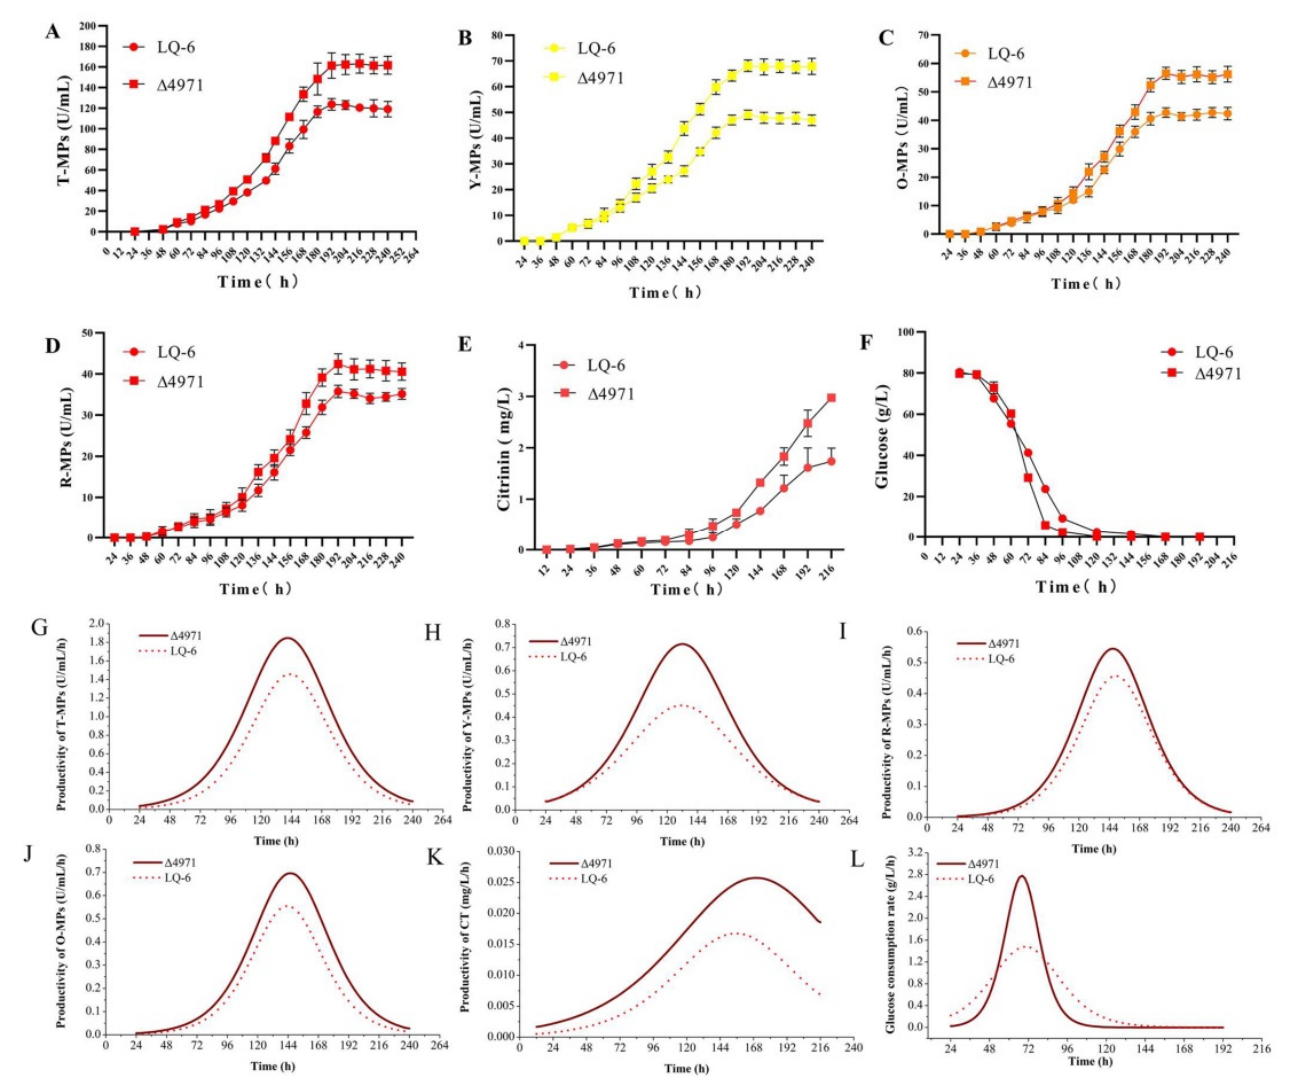
Figure 9. Submerged batch-fermentation kinetics analysis of M. purpureus LQ-6 and M. purpureus ∆ 4971. The biosynthesis of T-MPs ( A ), Y-MPs ( B ), O-MPs ( C ), R-MPs ( D ) and citrinin ( E ); glucose consumption ( F ); the productivity of T-MPs ( G ), Y-MPs ( H ), O-MPs ( I ), R-MPs ( J ) and citrinin ( K ); the rate of glucose consumption ( L ).